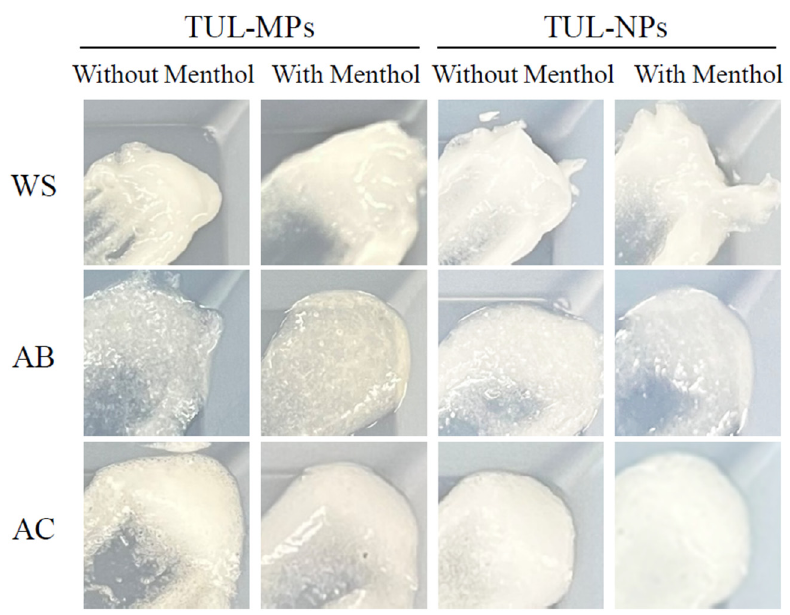
Figure 2. Digital images of ointments incorporating TUL-MPs and TUL-NPs. The compositions of ointments incorporating TUL-MPs and TUL-NPs are presented in Table 1.